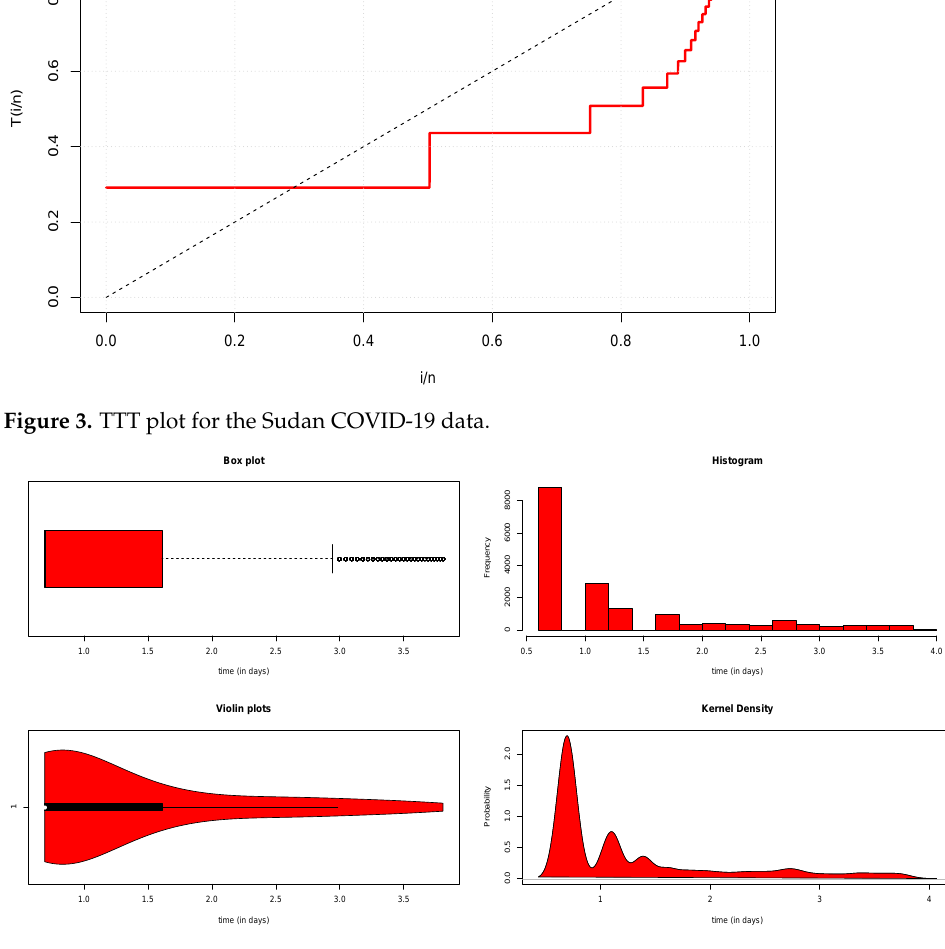
Figure 4. Some non-parametric plots for the Sudan COVID-19